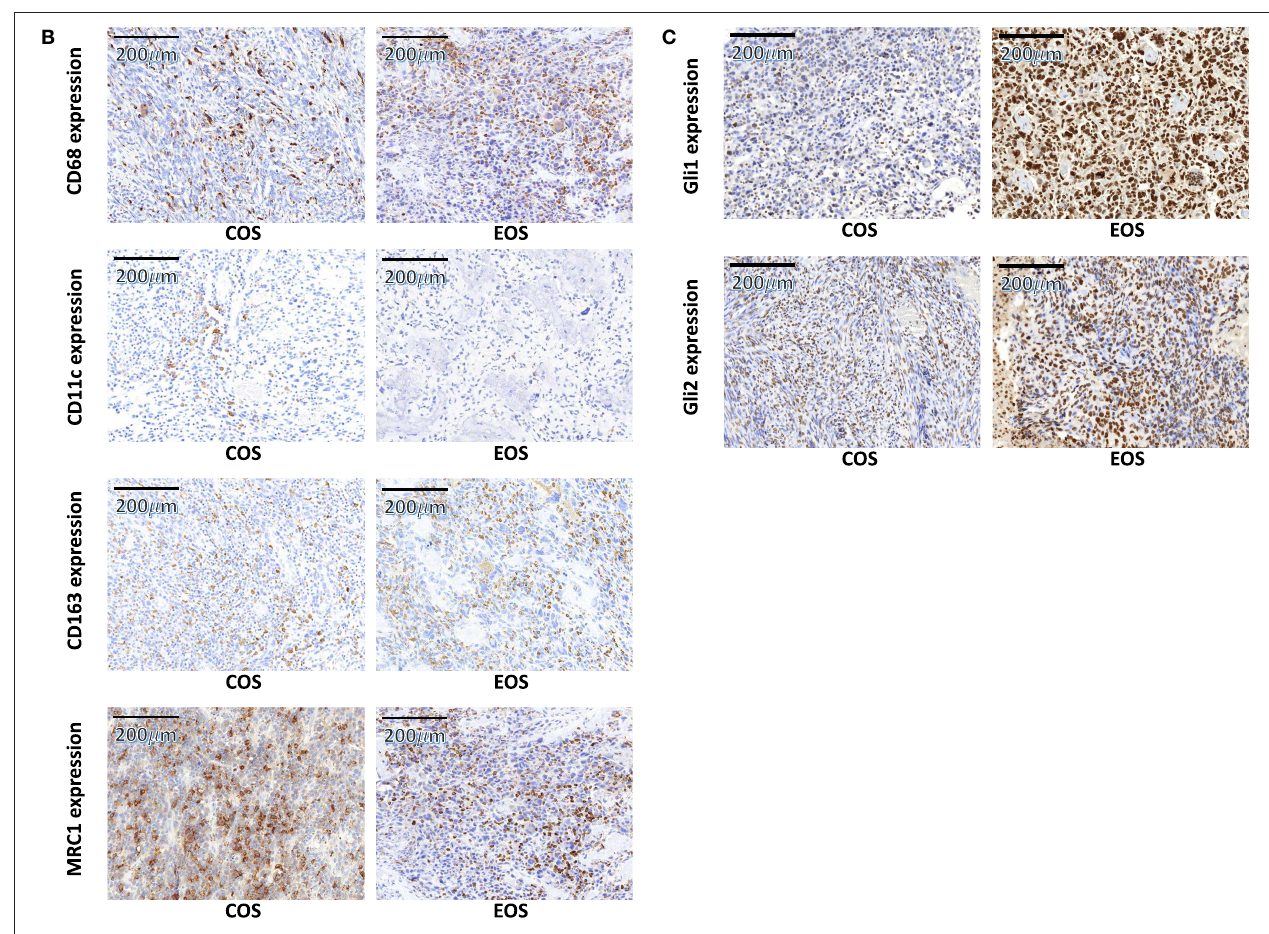
FIGURE 2 | Typical macrophage marker and Gli staining pattern. (A) shows exemplarily the typical expression pattern of the generic macrophage marker CD68 in a craniofacial osteosarcoma. CD68-positive cells are stained in brown. A panoramic view (2 × magnification) is given on the left side, and a magnification of the indicated region (25 × magnification) is displayed on the right side. Three fields of view are marked in the panoramic micrograph for cell counting. (B) shows high power micrographs (35 × magnification) of CD68, CD11c, CD163, and MRC1-positive macrophages in COS and EOS. All macrophage markers reveal acytoplasmic and membranous expression pattern. (C) shows high power micrographs (35 × magnification) of Gli1- and Gli2-positive tumor cells in COS and EOS. Both markers reveal a nuclear expression pattern. COS, craniofacial osteosarcomas; EOS, extracranial